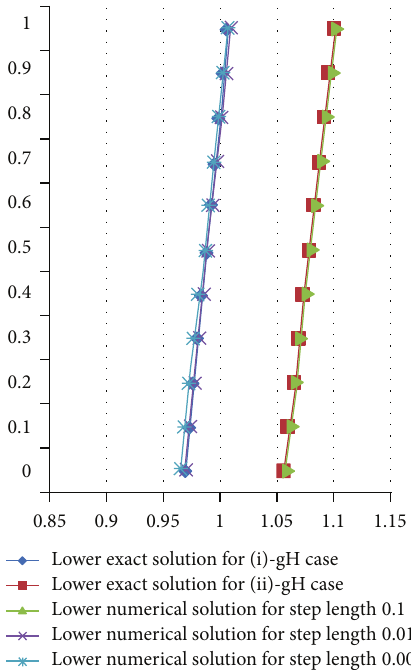
Figure 1: Comparison of lower exact solutions and numerical solution for different step lengths at 𝑡 = 0.1 .